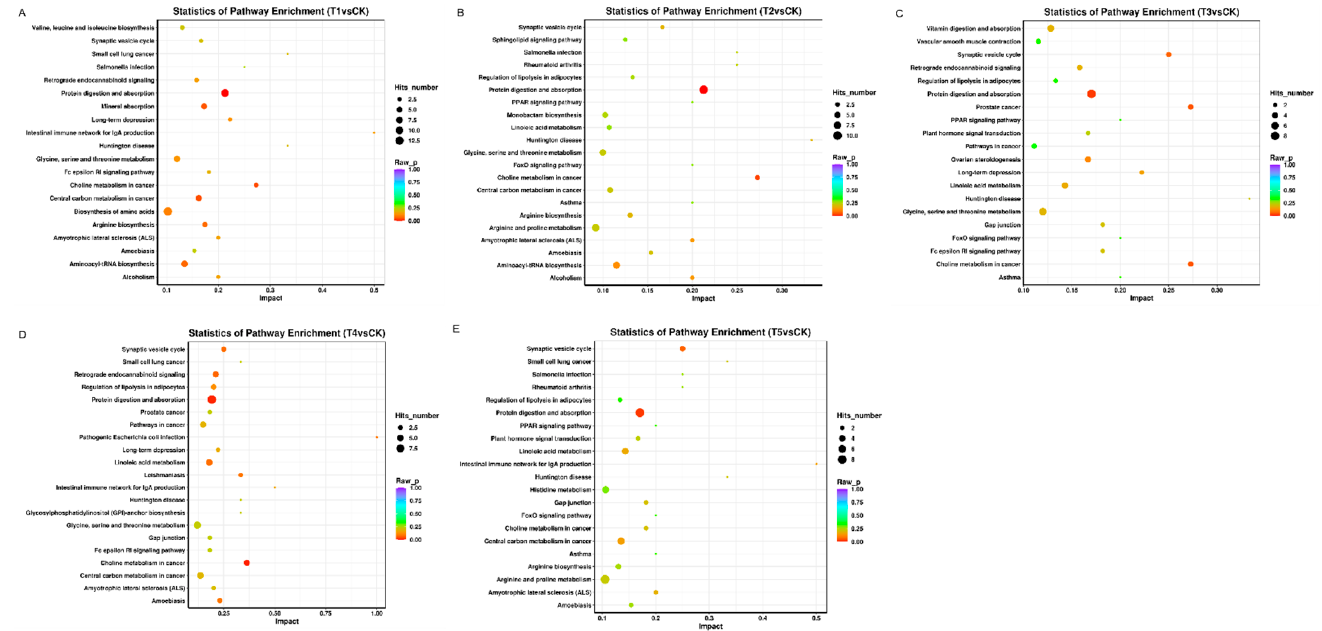
Figure 5. KEGG enrichment analysis scatter plot representing the pathways of DEGs in response to different fungal developmental stages of T. laevis infection. The blue, white, and red colors indicate low, medium, and high expression patterns of genes, respectively. ( A ) CK vs. T1 group. ( B ) CK vs. T2 group. ( C ) CK vs. T3 group. ( D ) CK vs. T4 group. ( E ) CK vs. T5 group. CK stands for control, QC stands for quality control, T1 stands for the suspension of teliospores, T2 stands for promycelia, T3 stands for primary basidiospores, T4 stands for H-bodies, and T5 stands for secondary basidio- spores.